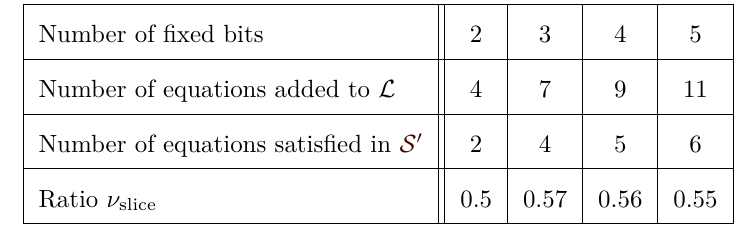
Table 2: Different choices for the number of fixed bits per slice when the outer state is made of one